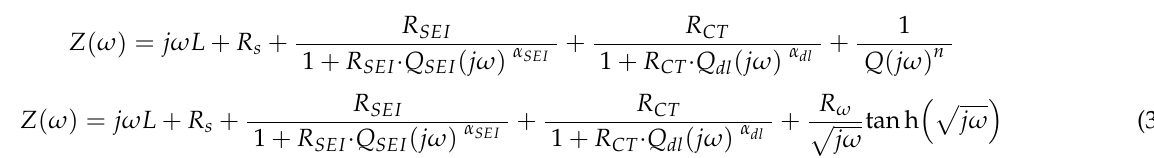
Figure 5. Electrical equivalent circuit of a cylindrical Li-ion battery. For a cylindrical Li-ion battery, since the parallel plate battery is wound into a cylinder, the series inductor ( L S ) is relatively larger than that for a pouch-type battery, and the R S of the battery is arranged in series